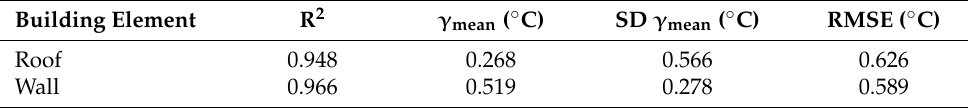
Table 5. Experimental validation of model statistical